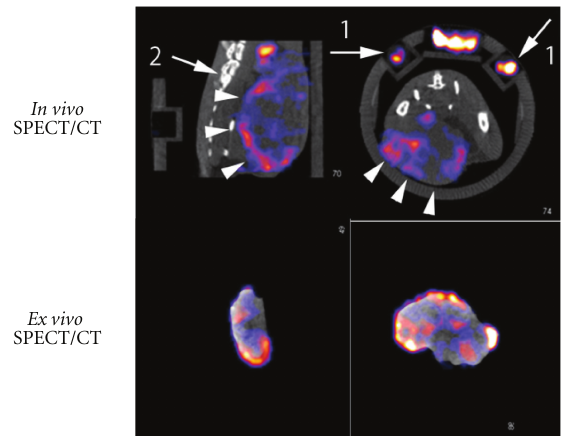
Figure 3: In vivo visualization of heterogeneous intratumoral distribution of POS by SPECT/CT. The comparison of in vivo SPECT images and ex vivo images. Upper raw: in vivo SPECT images, lower raw: ex vivo SPECT images, left column: sagittal sectional images, right column: axial sectional images. Arrows 1: markers for coregistration, arrows 2: vertebrae, and arrowheads: the tumor.